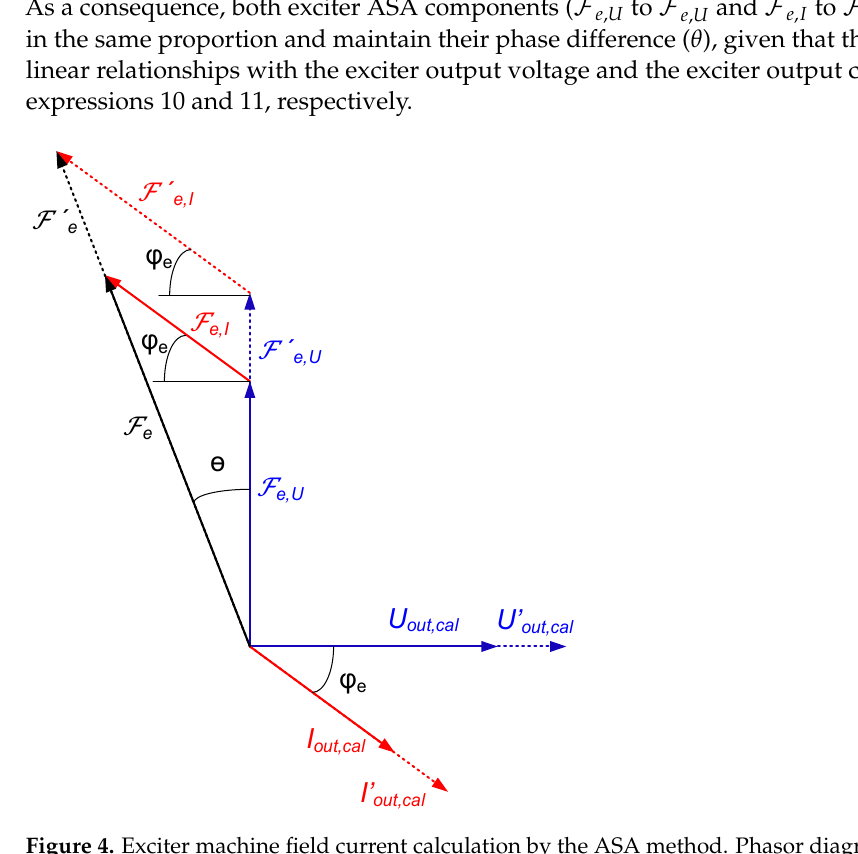
Figure 4. Exciter machine field current calculation by the ASA method. Phasor diagram.